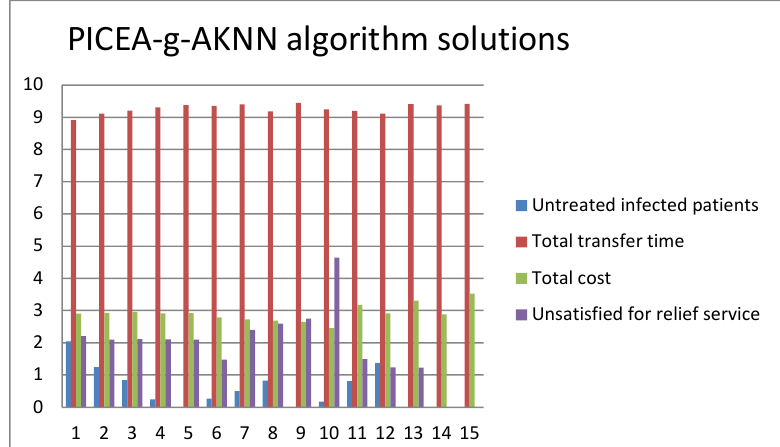
Figure 7. Results for a small test problem by the PICEA-g-AKNN algorithm.